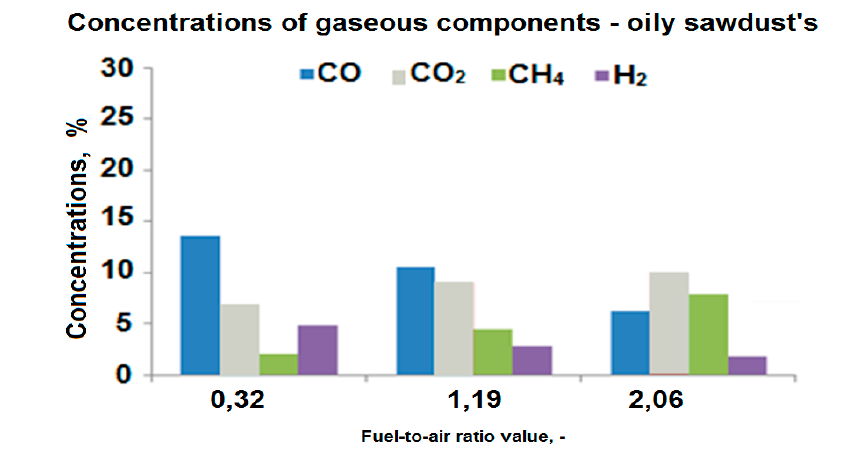
Figure 2. Concentrations of gaseous components—oily